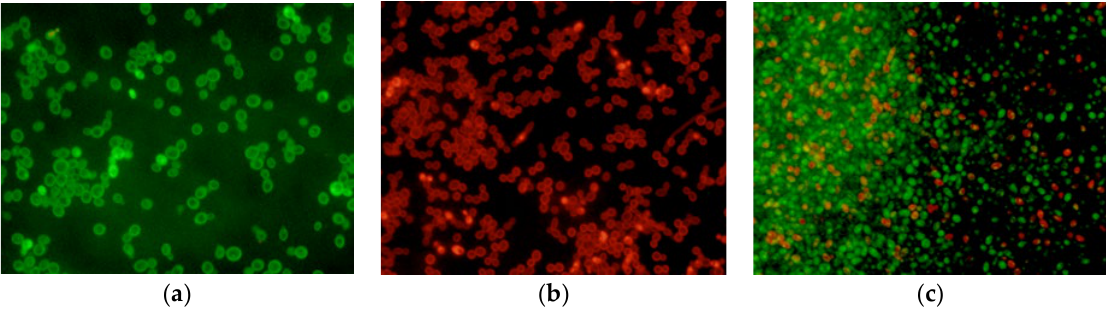
Figure 5. Fluorescence microscopy of C. tropicalis without treatment ( a ), treated with ISO ( b ) and treated with FLZ ( c ) after 24 h. Live cells with intact membranes appear green, while dead cells with damaged membranes appear red.